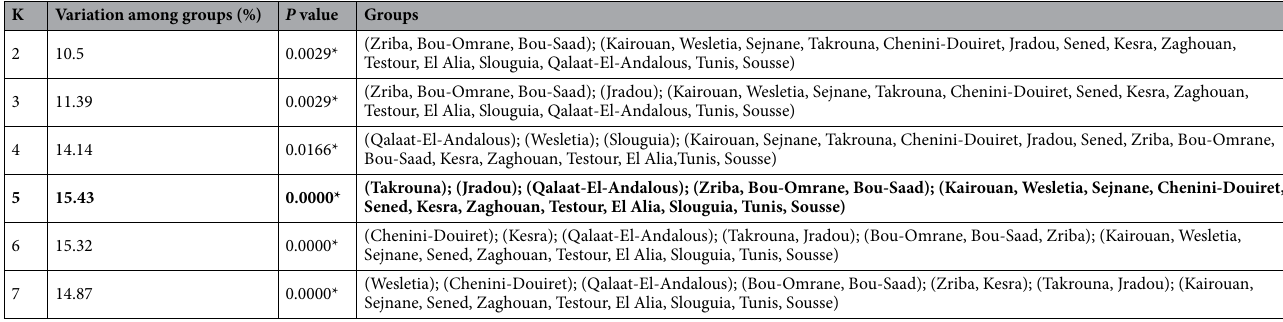
Table 3. SAMOVA results for different population partitions. K: Number of groups; In bold: group with the highest F CT value. * P value <